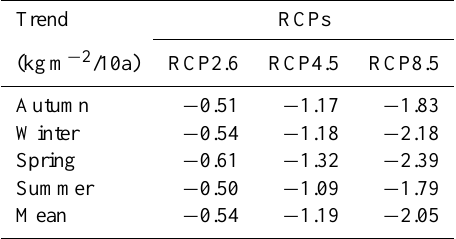
Table 3. Trends in SWE over Northern Hemisphere land during 2006–2099 derived from the three RCPs. All trends are significant at 95% confidence level (Mann–Kendall